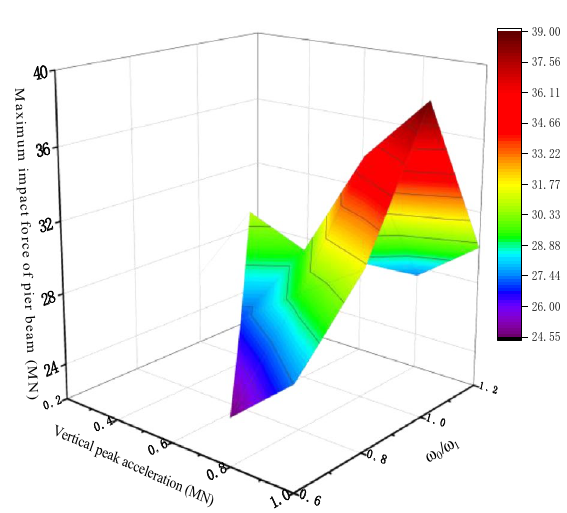
Figure 5. The vertical impact force of pier beam.